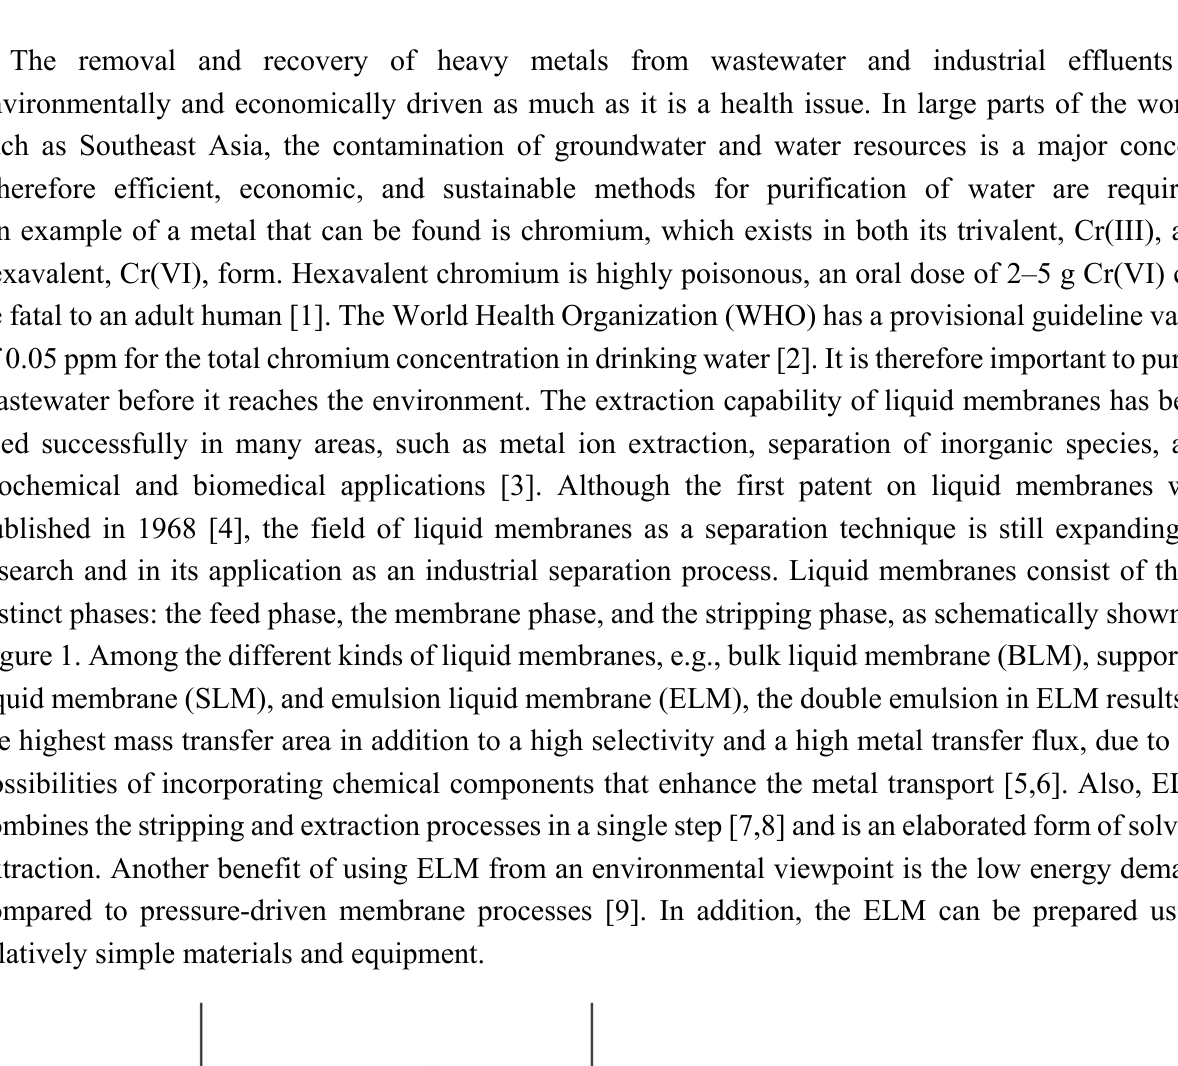
Figure 1. Among the different kinds of liquid membranes, e.g., bulk liquid membrane (BLM), supported